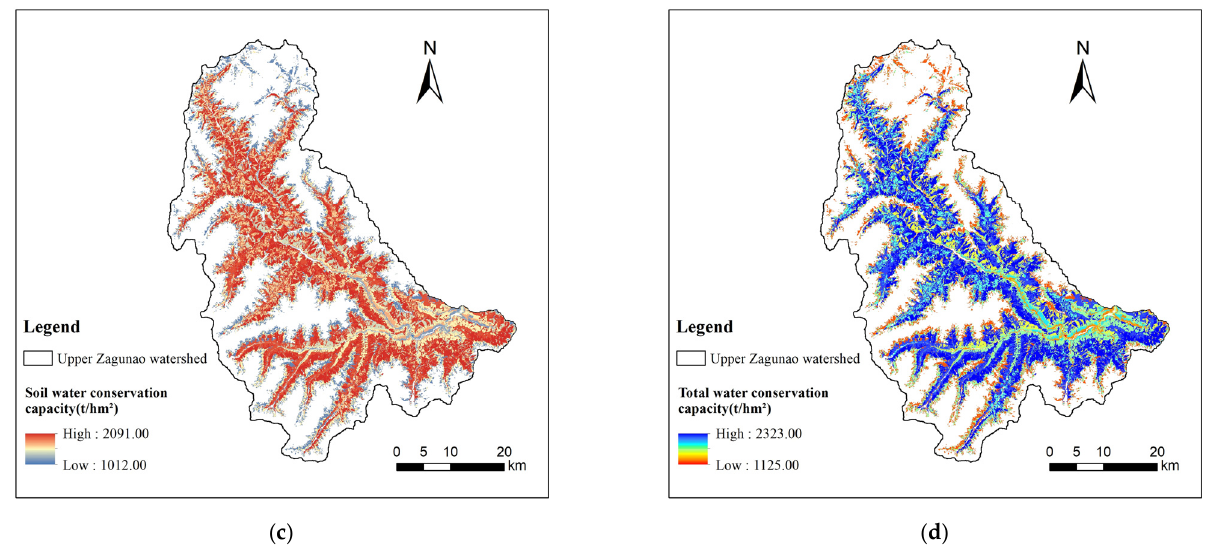
Figure 9. Spatial distribution of ( a ) canopy, ( b ) litter, ( c ) soil and ( d ) total water conservation capacity under artificial restoration scenarios in 2030.